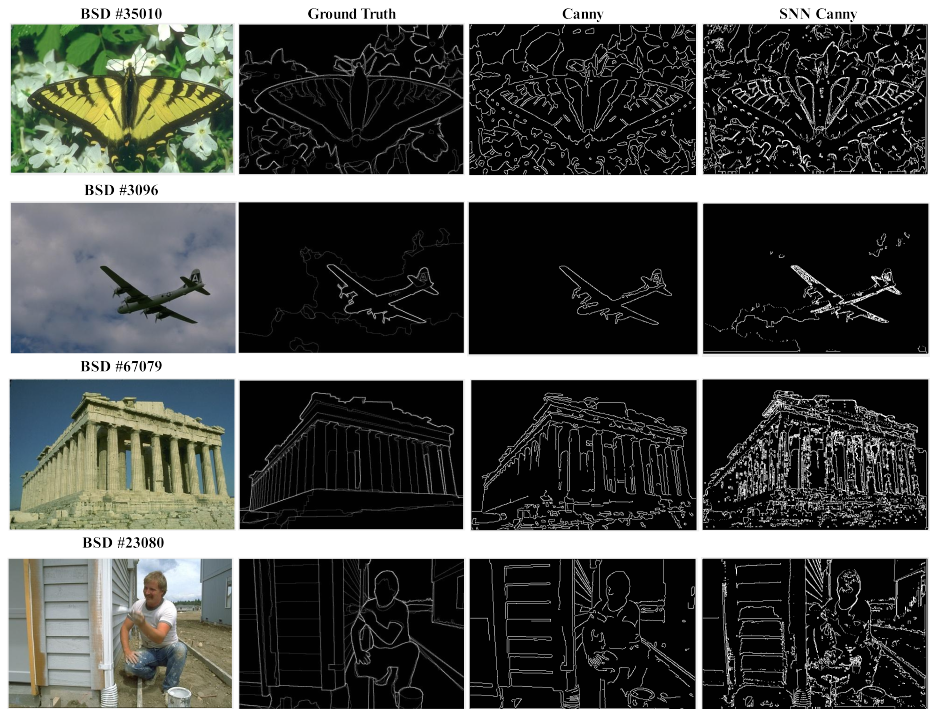
Figure 3. A comparison of the ground truth with the results from Canny edge detector and the SNN analogue of Canny edge detector for selected images from BSD500